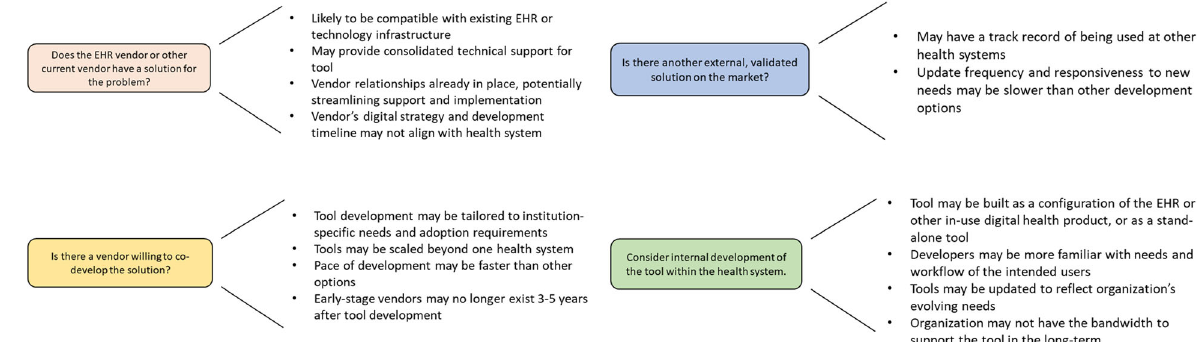
Fig. 1 Approaches to digital health tool selection. Various digital health-product-selection approaches, and important considerations for each approach. We recommend investigating the viability of all four possibilities in parallel; the optimal approach will depend on the type of problem being addressed and characteristics of the health